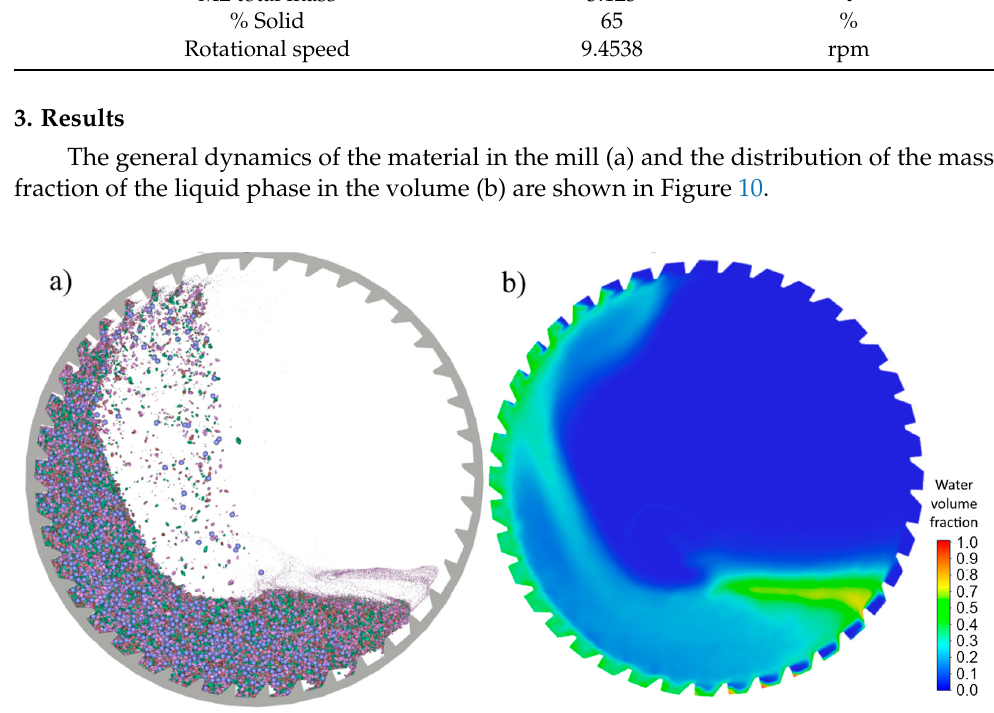
Figure 10. General dynamics of the material in the mill ( a ) and the distribution of the mass fraction of the liquid phase ( b ).